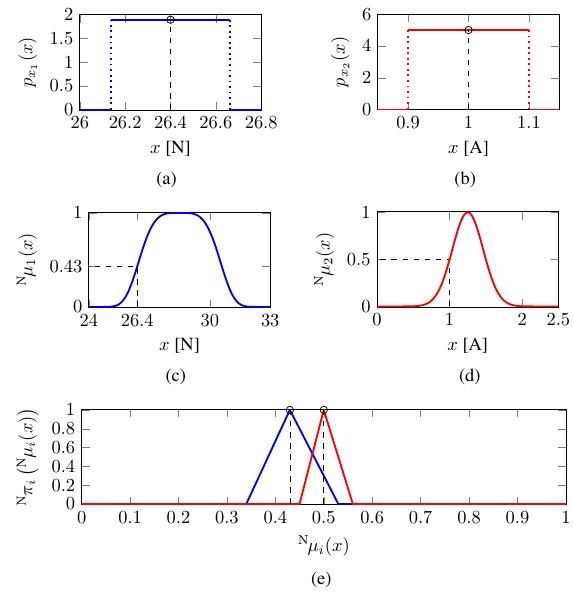
Figure 5. Exemplary determination of the sensor observations N π 1 and N π 2 on fuzzified measurement scales. The plots depict the re- spective functions of sensor S 1 measuring a force in N in blue, and those of sensor S 2 measuring an electric current in A in red. Note the incomparable measurement ranges and physical units, which are transformed step-by-step from (a) to (e) into a common space ( a , b : sensor characteristics at measurement value x i (given by the dashed stem) represented by uniform probability density functions; c , d : fuzzy membership functions N µ i modelling the normal condition as acquired by the respective sensor along with the fuzzified mea- surement value (given by the dashed line); e sensor observations as determined by the truncated triangular probability–possibility trans- form on the common fuzzified measurement scale along with the respective fuzzified measurement (given by the dashed stems)). The majority observation is visible in (e) in the overlapping region of the two